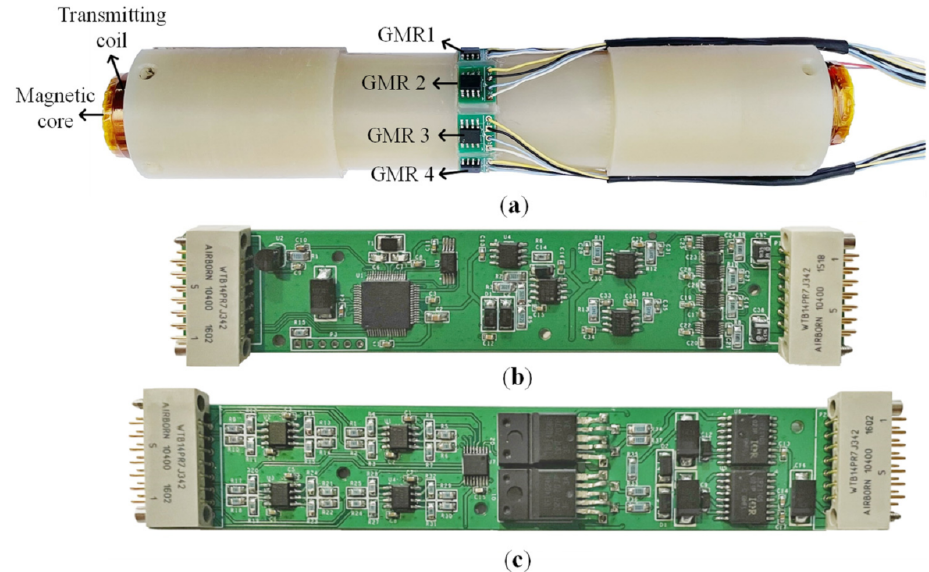
Figure 9. Probe structure and the corresponding circuit board for the synthesized UCA: ( a ) Probe structure of synthesized UCA; ( b ) data acquisition circuit; ( c ) transmitting and receiving